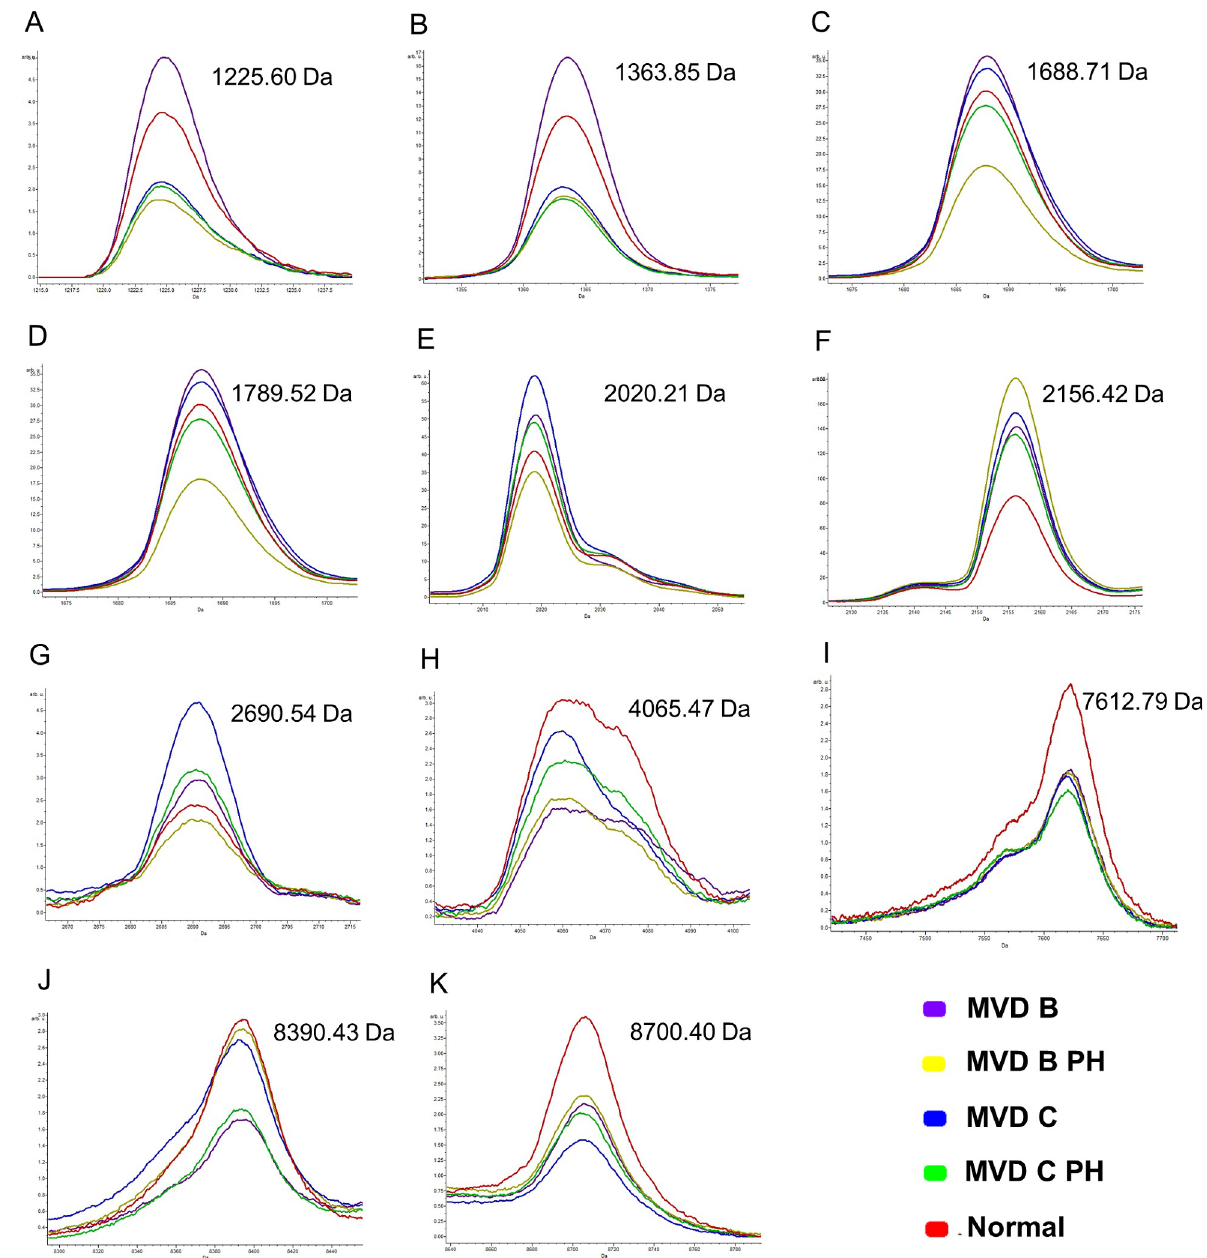
Fig 3. Magnified view of different mass spectral peaks of peptide barcodes among all 5 groups from Fig 2.